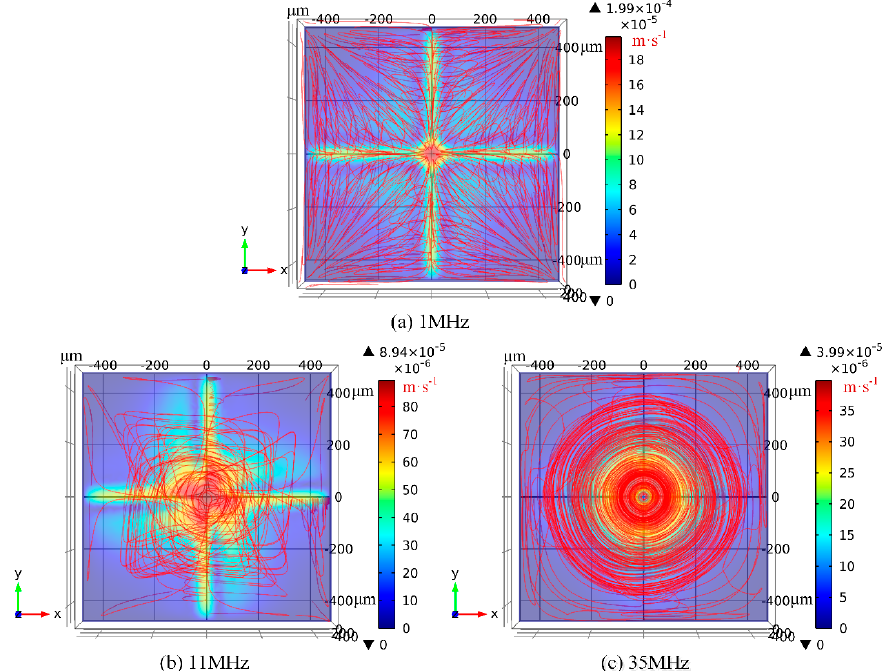
Figure 5. Simulation results of ROT-ETF flow field under distinct field frequencies where electrode cooling effect is taken into account: ( a ) f = 1 MHz for low-frequency limit; ( b ) f = 11 MHz at the characteristic dispersion frequency; ( c ) f = 35 MHz within the high-frequency range.